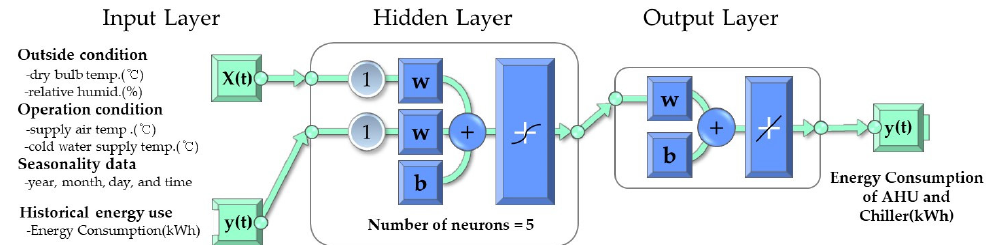
Figure 1. Schematic of the ANN model for predicting energy consumption.